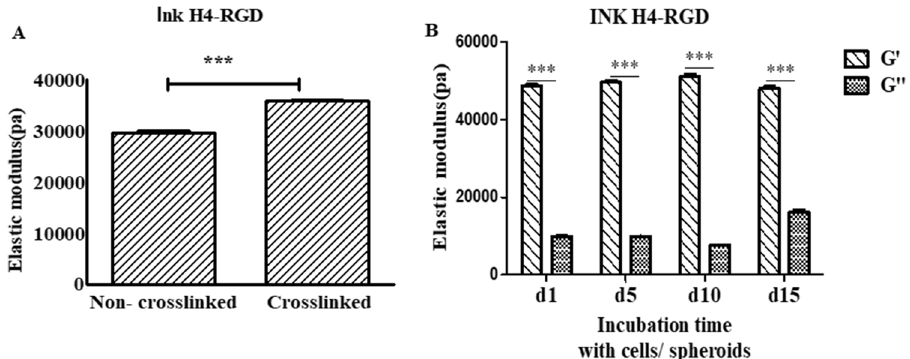
Figure 6. Rheological properties of the hydrogel and stiffness of cell laden scaffolds. ( A ) Elastic modulus of crosslinked Ink H4-RGD without cells/spheroids. ( B ) Elastic modulus of cell laden scaffolds when incubated at 37 °C and 5% CO 2 for 15